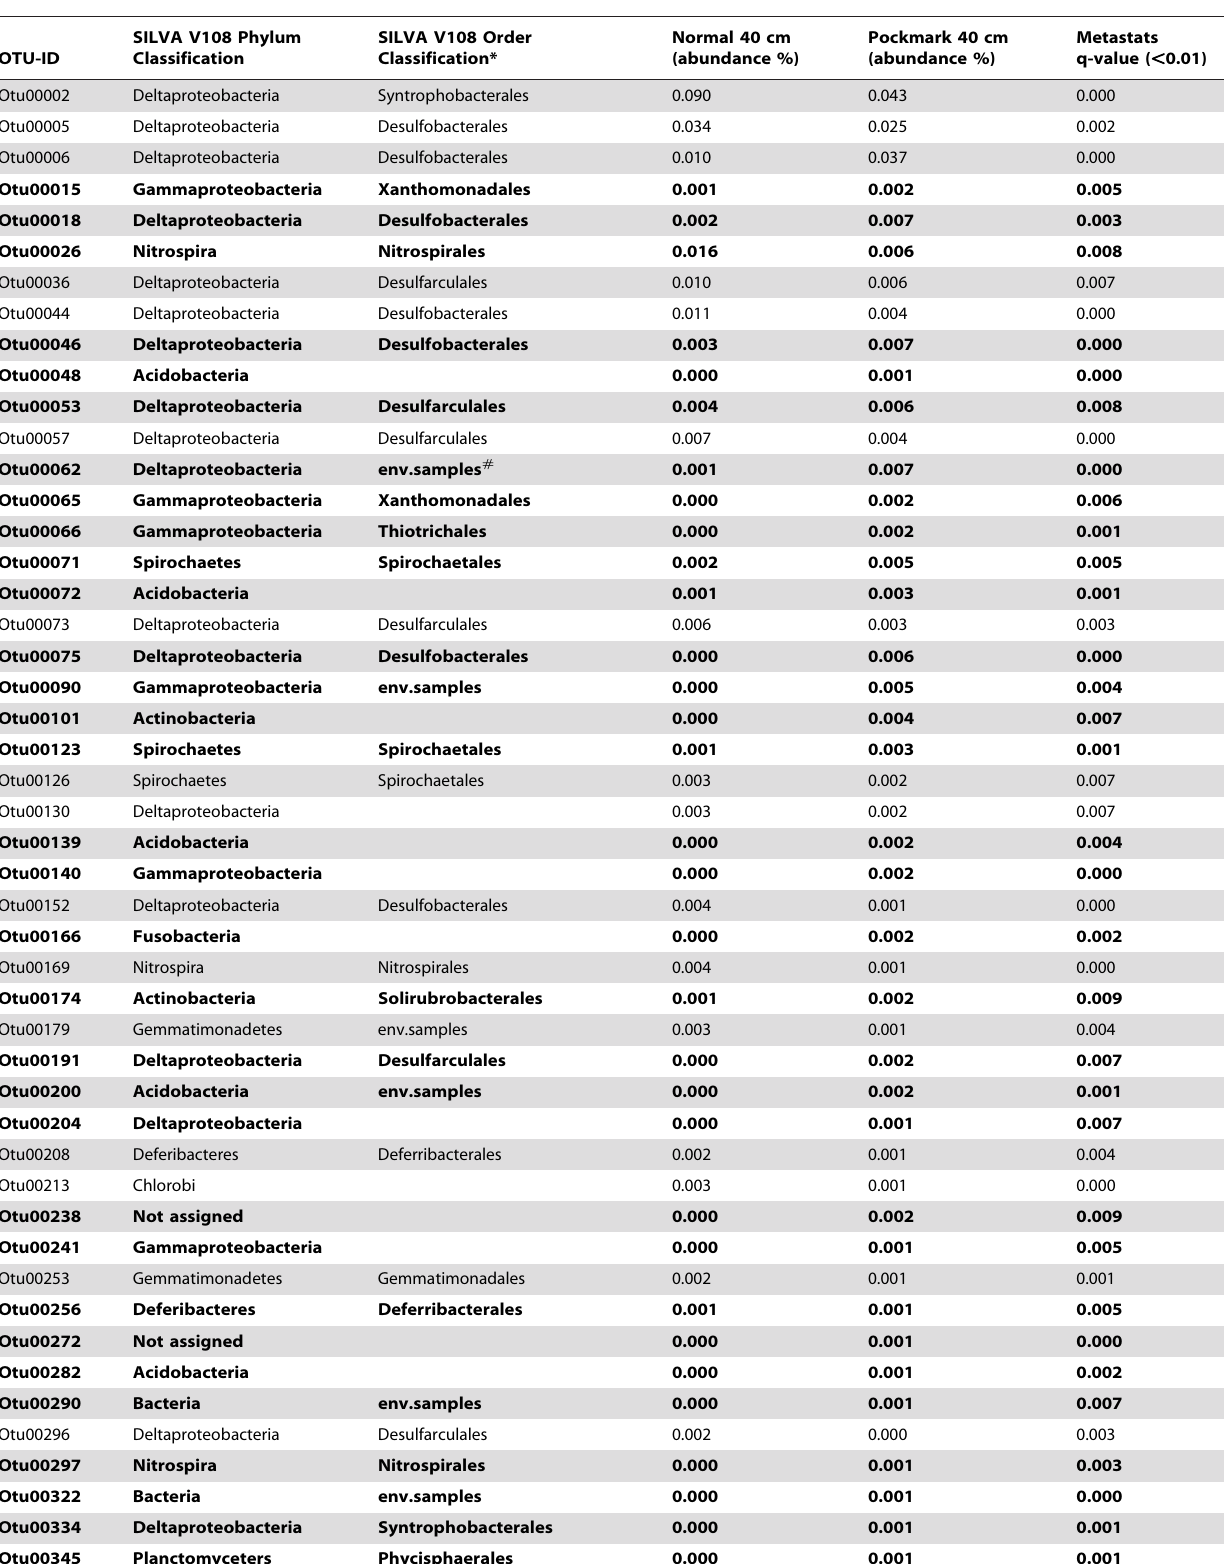
Table 4. Metastats results of OTUs with significantly different abundances between the 40 cm pockmark and reference sediment